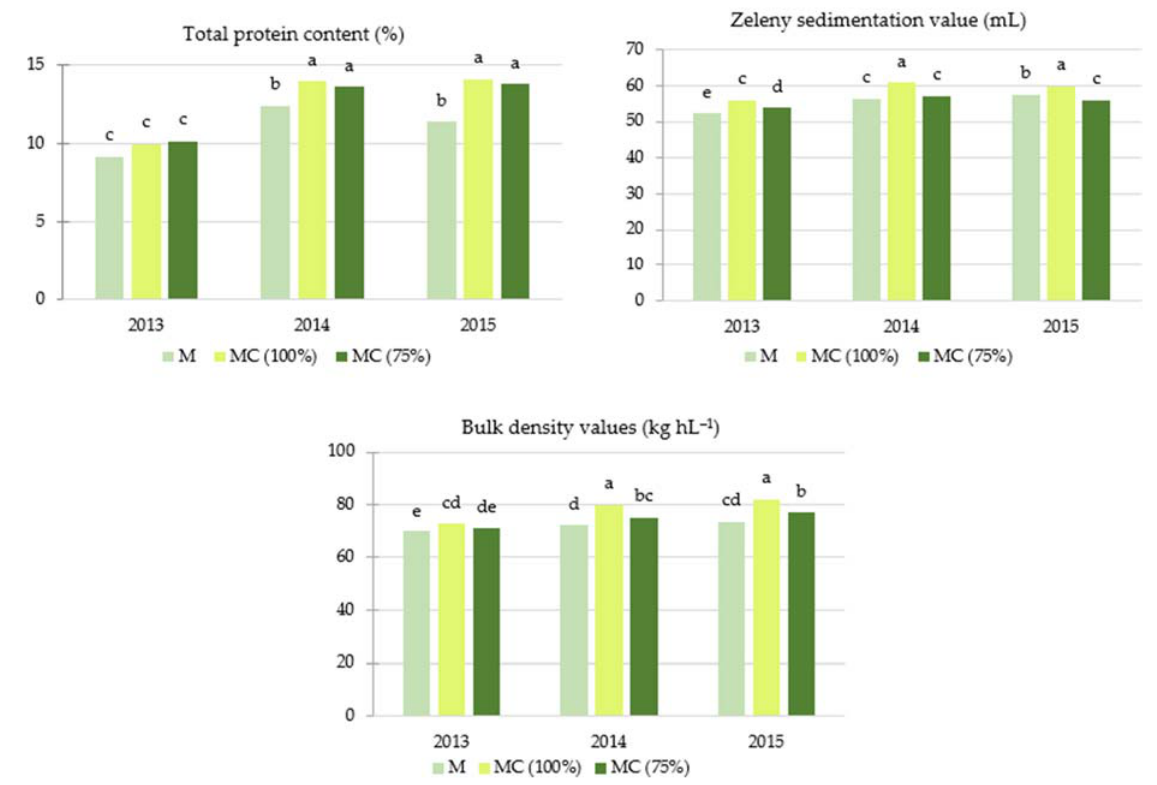
Figure 6. Interaction of the weed control method and research years in determining quality param- eters of spelt wheat grain. M—mechanical; MC (100%)—mechanical and chemical (dose of herbi- cides 100%); MC (75%)—mechanical and chemical (dose of herbicides 75%). Different letters denote significant differences ( p ≤ 0.05). The same letter represents not significantly different values ( p ≤ 0.05).